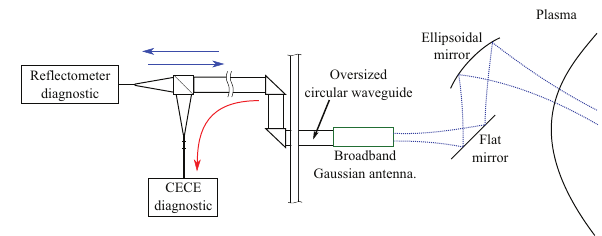
Figure 4. Adapted from [13]. A schematic of the CECE waveg- uide and optical setup. The CECE is set up to use the same line of sight as a reflectometer, coupled via a 3dB wire-grid splitter.